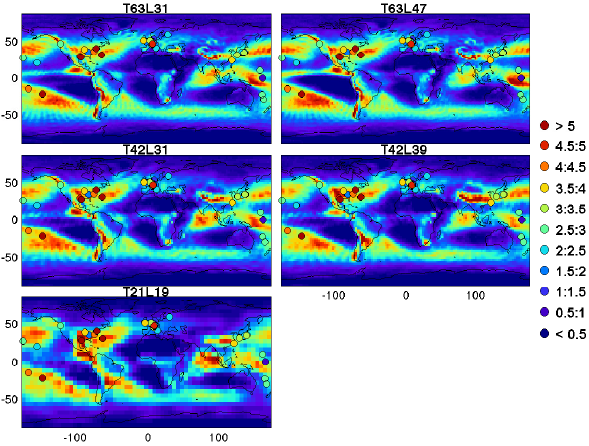
Fig. 6. 1998–2002 mean deposition flux of 10 Be atoms (100 m − 2 s − 1 ) with different model resolutions. The dots show the location and observed deposition flux at 21 stations (references given in the text).